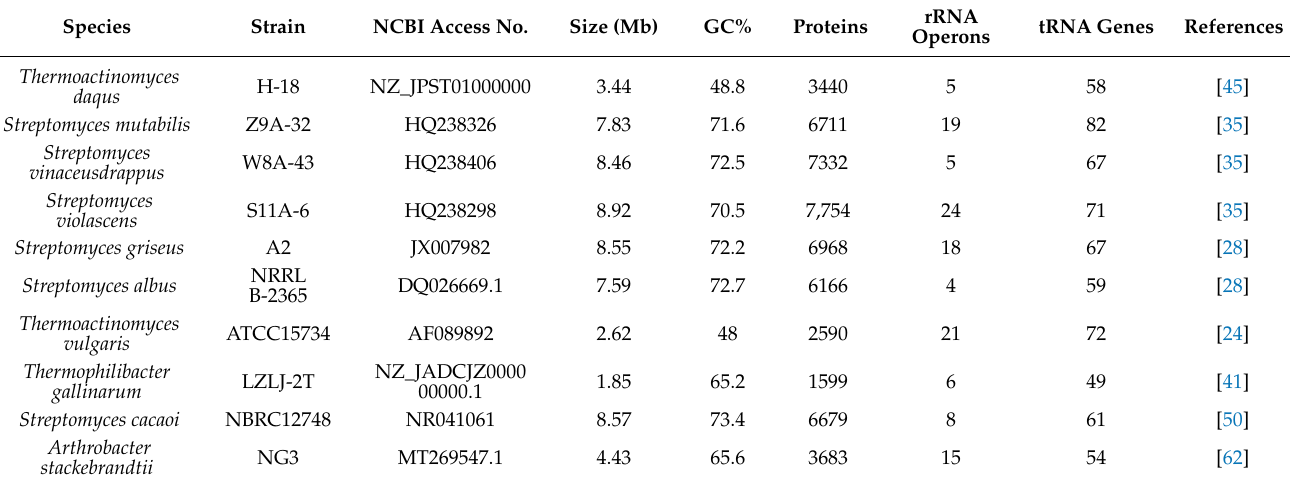
Table 3. Genomic features of the actinomycetes isolated from